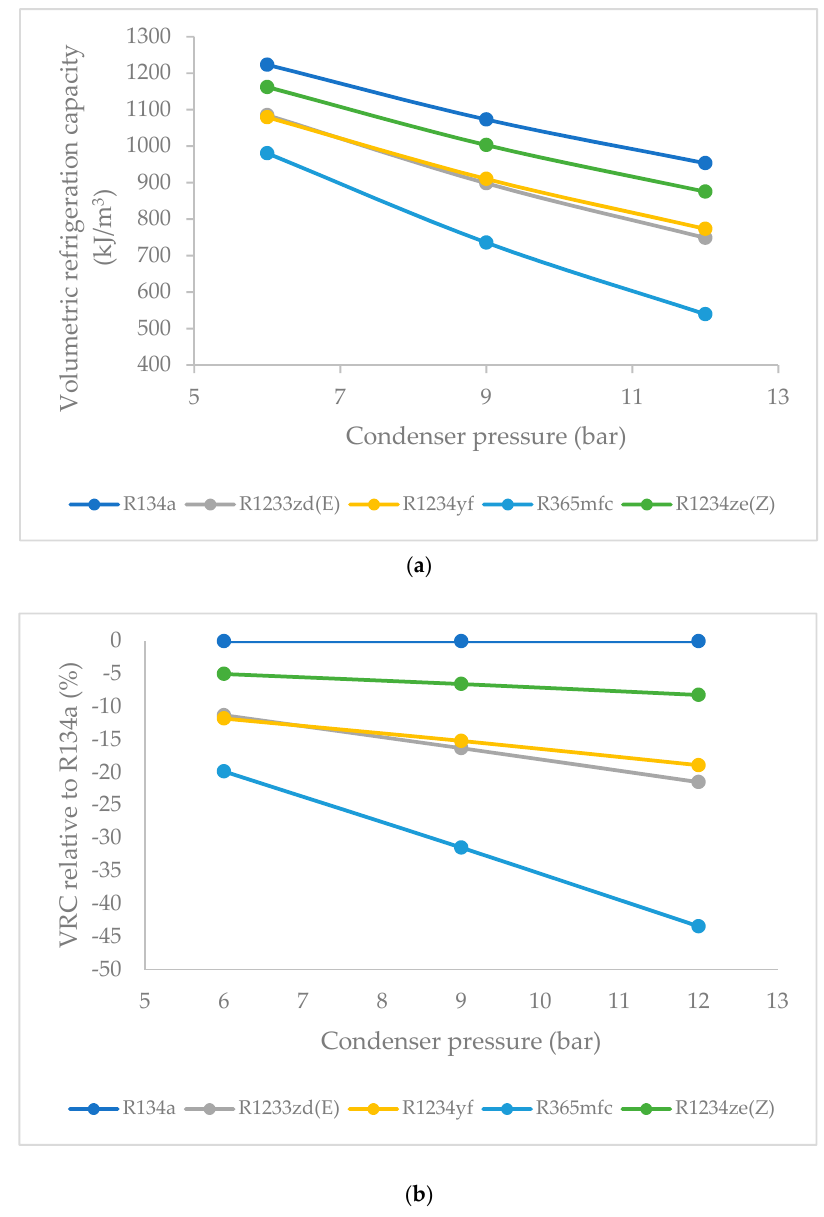
Figure 12. ( a ) Volumetric refrigeration capacity (VRC) as a function of condenser pressure (evaporator pressure = 1.5 bar). ( b ) VRC relative to R134a (%) (evaporator pressure = 1.5 bar).